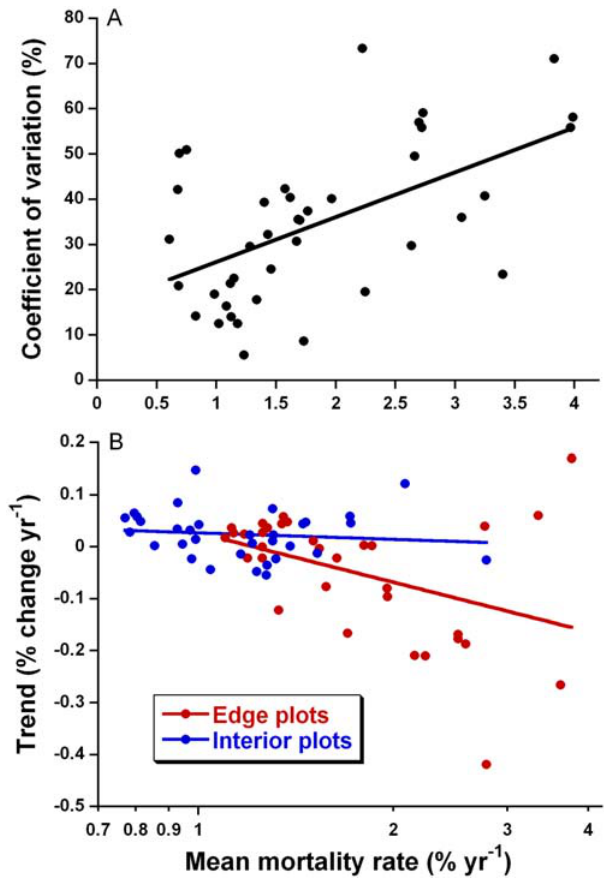
Figure 4. Temporal variability in tree mortality. (A) Tree mortality is highly episodic in Amazonian forest fragments, as shown by the strong relationship between the mean and CV of mortality rates, based on repeated censuses of 1-ha plots ( F 1,64 =13.17, R 2 =17.1%, P =0.0006). (B) Mortality rates decline with fragment age, but only among plots near forest edges ( F 1,31 =6.49, R 2 =17.3%, P =0.016), which have the highest overall mortality rates (there was no significant trend for forest-interior plots; F 1,31 =0.42, R 2 =1.3%, P =0.52; linear